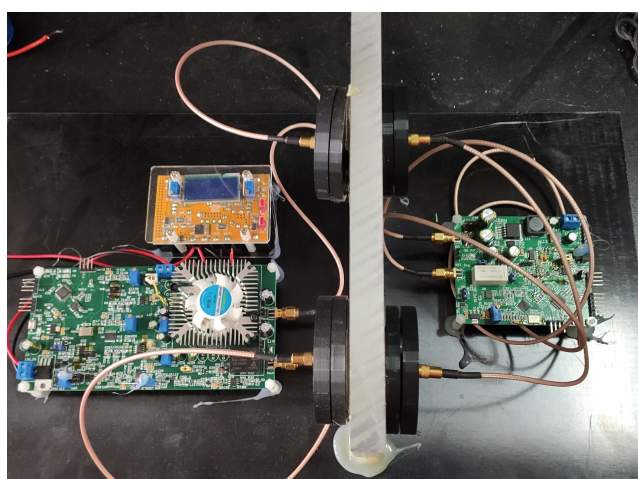
Figure 15. Prototype with two pairs of piezoelectric transducers (PZTs) for simultaneous power transfer and bi-directional communication.